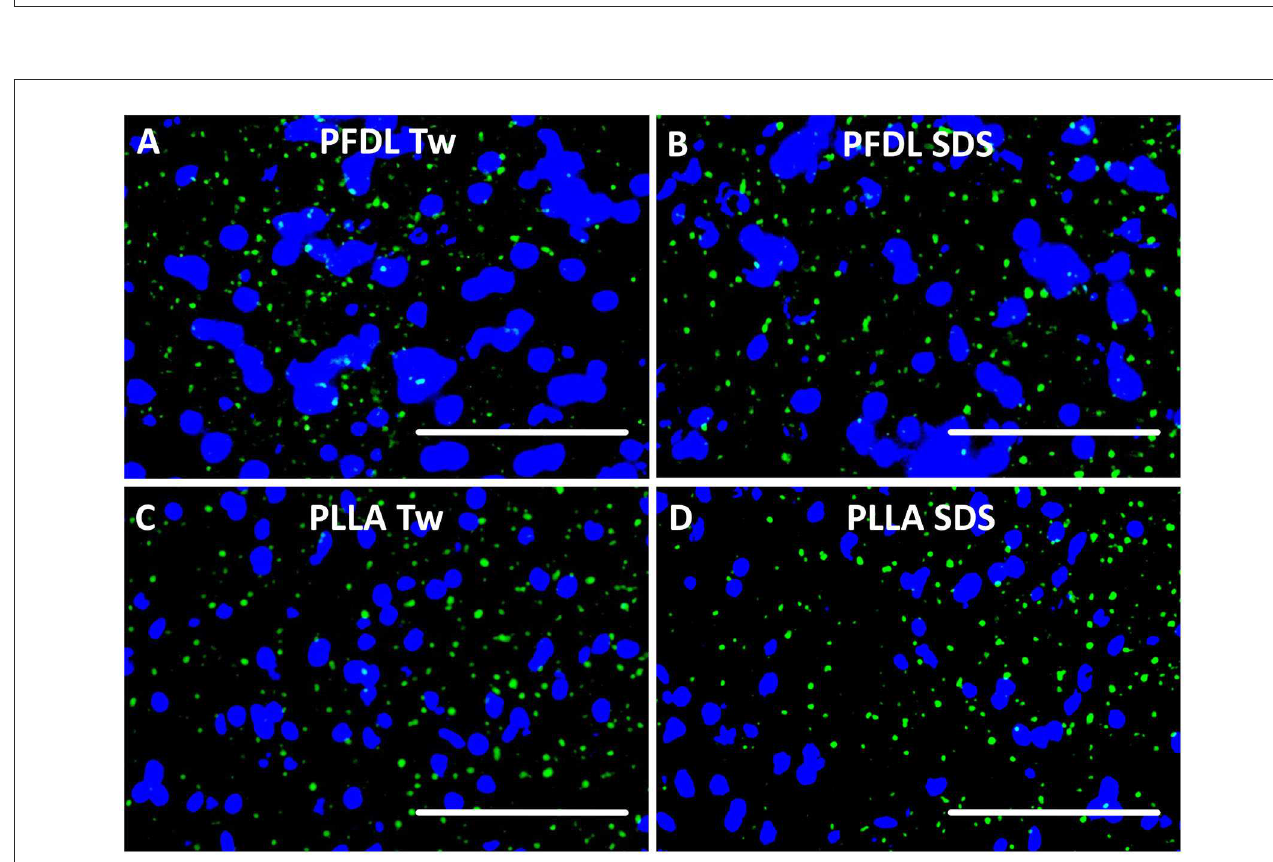
FIGURE2 NP visualization after intravenous application. Each NP has been injected intravenously at a dose of 10,000 µ g/kg body weight. Tissue sections were yielded 4 and 24h after treatment and evaluated under fluorescence microscopy. In this example, green fluorescence of PFDL-Tw (A) , PFDL-SDS (B) , PLLA-Tw (C) , and PLLA-SDS (D) can be identified and differentiated from the DAPI in brain sections, taken from the right parietal cortex (Bregma − 3.00mm), 4h after intravenous application. White bars indicate 50 µ